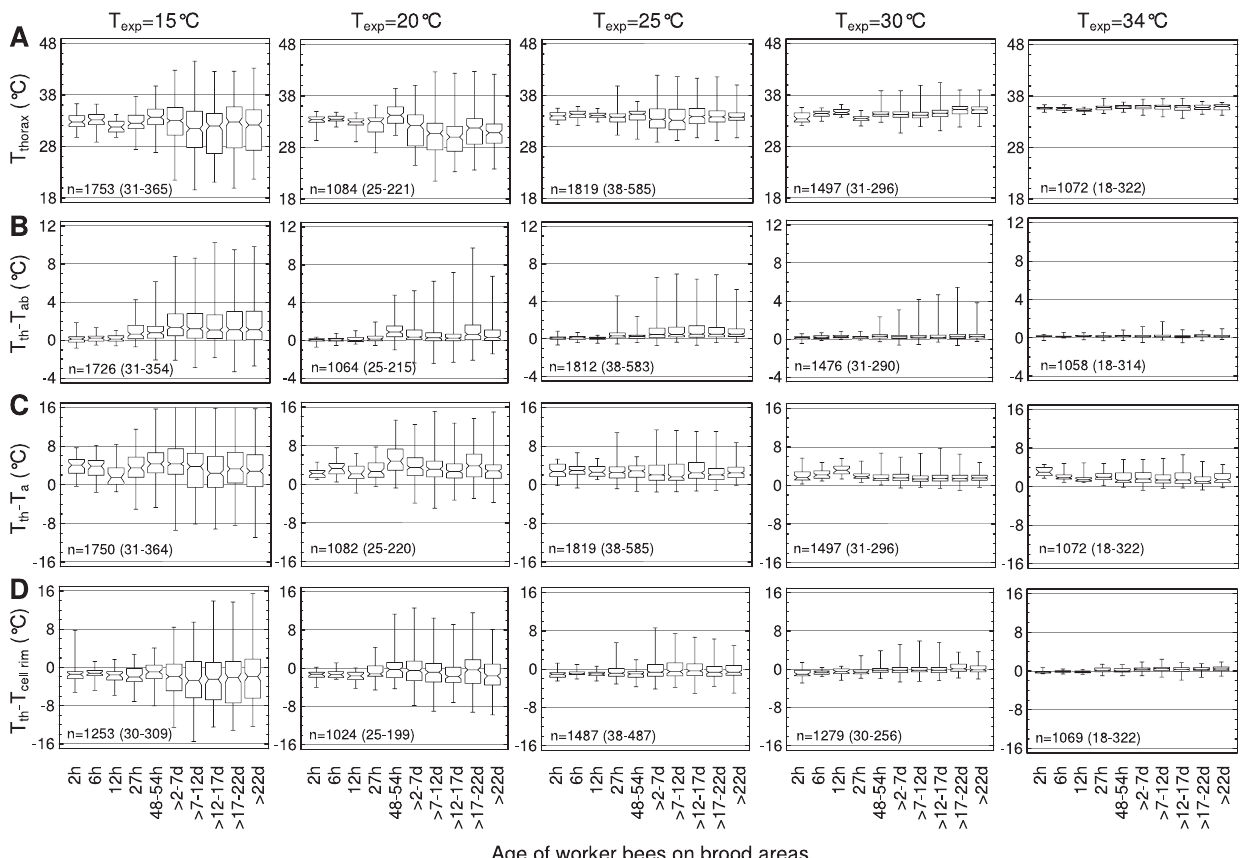
Figure 4. Body temperature and temperature excess of workers of different ages on brood in dependence on thermal stress (T exp ). Box plots: median with 1 st and 3 rd quartile, maximum and minimum of (A) T thorax , (B) T thorax -T abdomen , (C) T thorax -T a , and (D) T thorax -T cell rim . n=measurements (bees) (range in parenthesis).